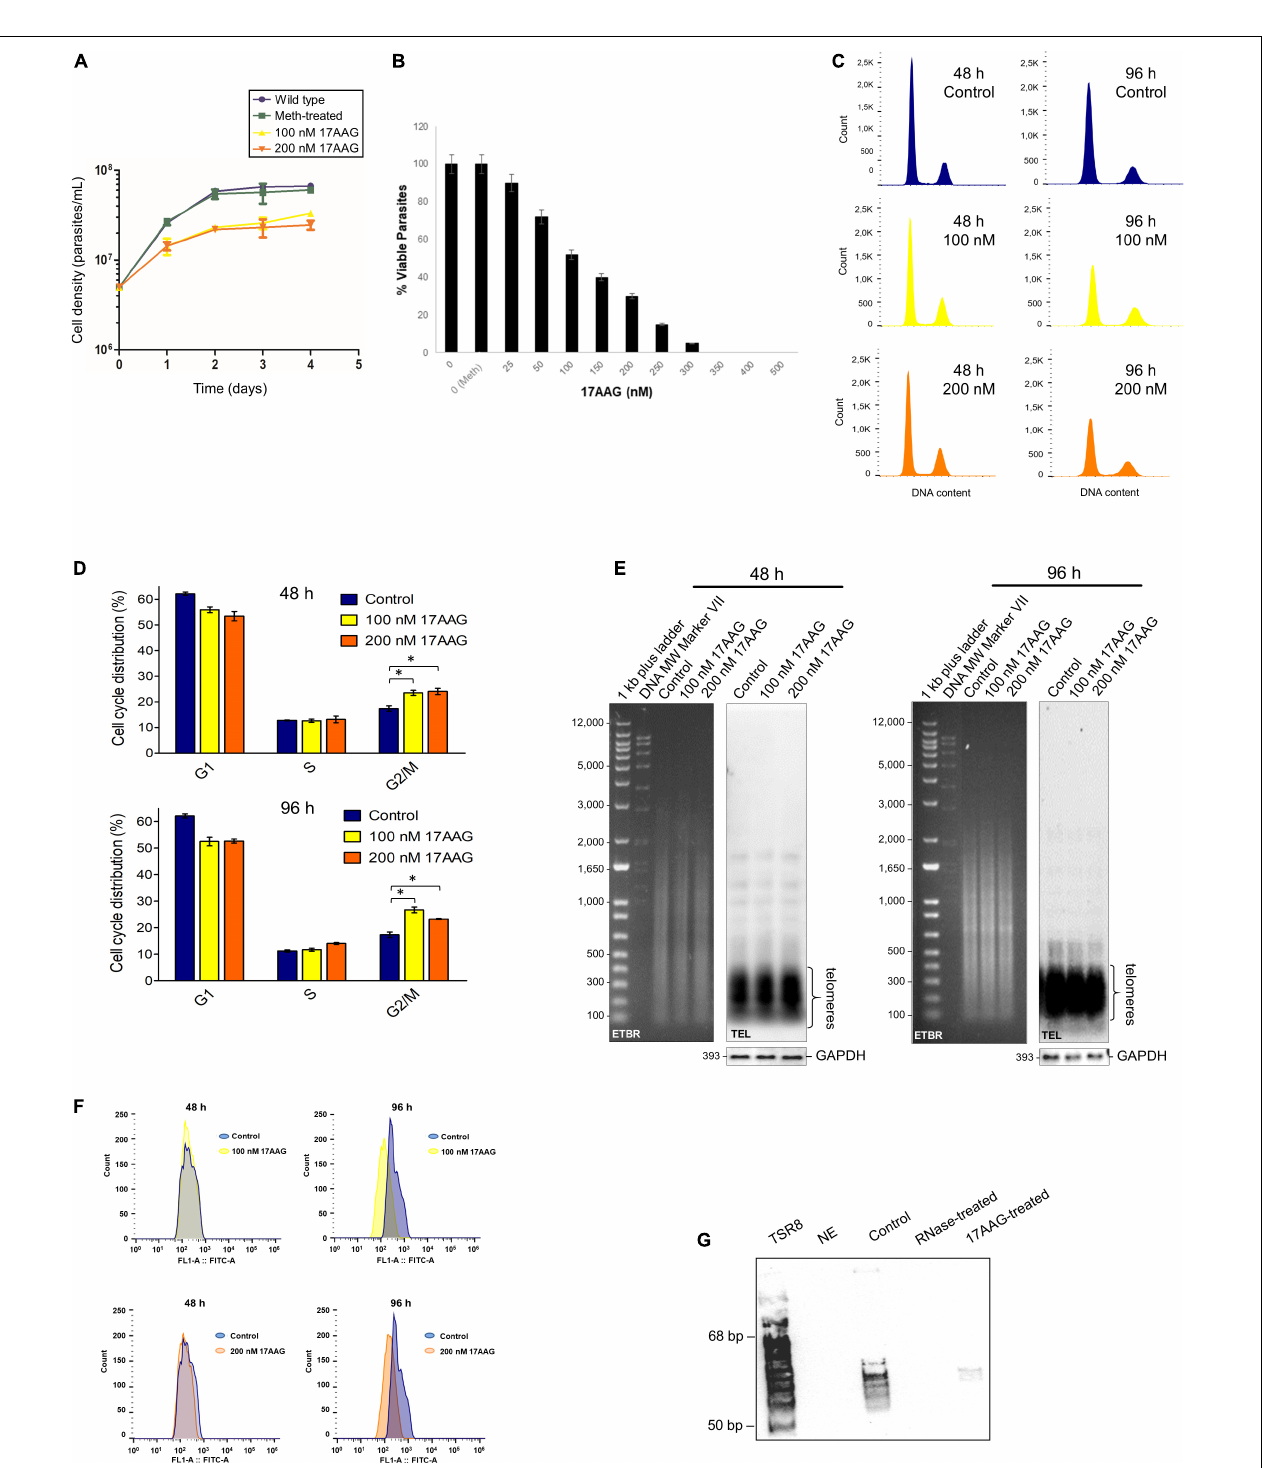
FIGURE 3 | The inhibitor of HSP90, 17AAG, induces cell death, cell cycle arrest, telomere shortening, and telomerase inhibition in L. amazonensis PP. (A) Growth curves of PP non-treated (Wt and meth-treated parasites) and treated with 17AAG), maintained in exponential growth for 96 h and counted in the Neubauer chamber every 24 h. Wt and meth-treated parasites were used as the control. Treated parasites were cultivated in the presence of 100 and 200 nM 17AAG. (B) Cells’ viability test. L. amazonensis PP ( ∼ 3 × 10 6 cells) in exponential growth were treated for 48 h at 28 ◦ C with increased concentrations of 17AAG. As a control, cells were grown in the absence (0) and the presence of methanol (0 Meth). The assay was done using PrestoBlue (Invitrogen) according to the manufacturer’s